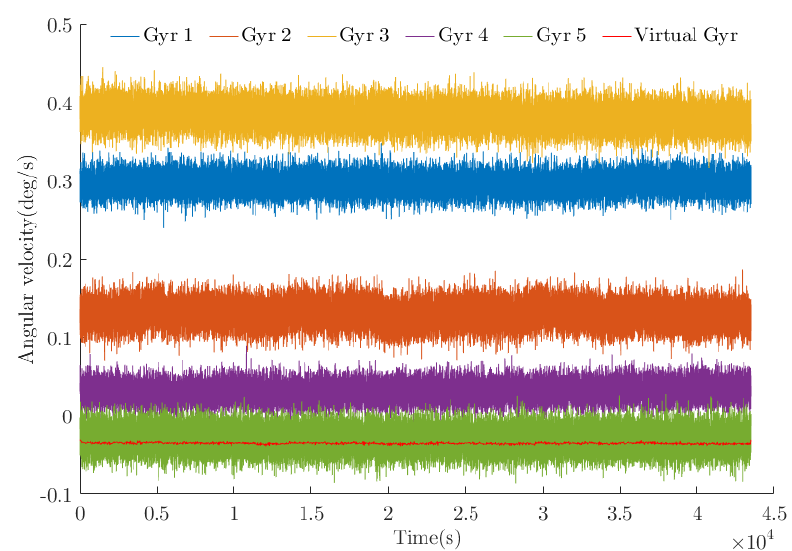
Figure 9. Comparison of the original wavelet coefficients and the optimal estimate of the wavelet coefficients.